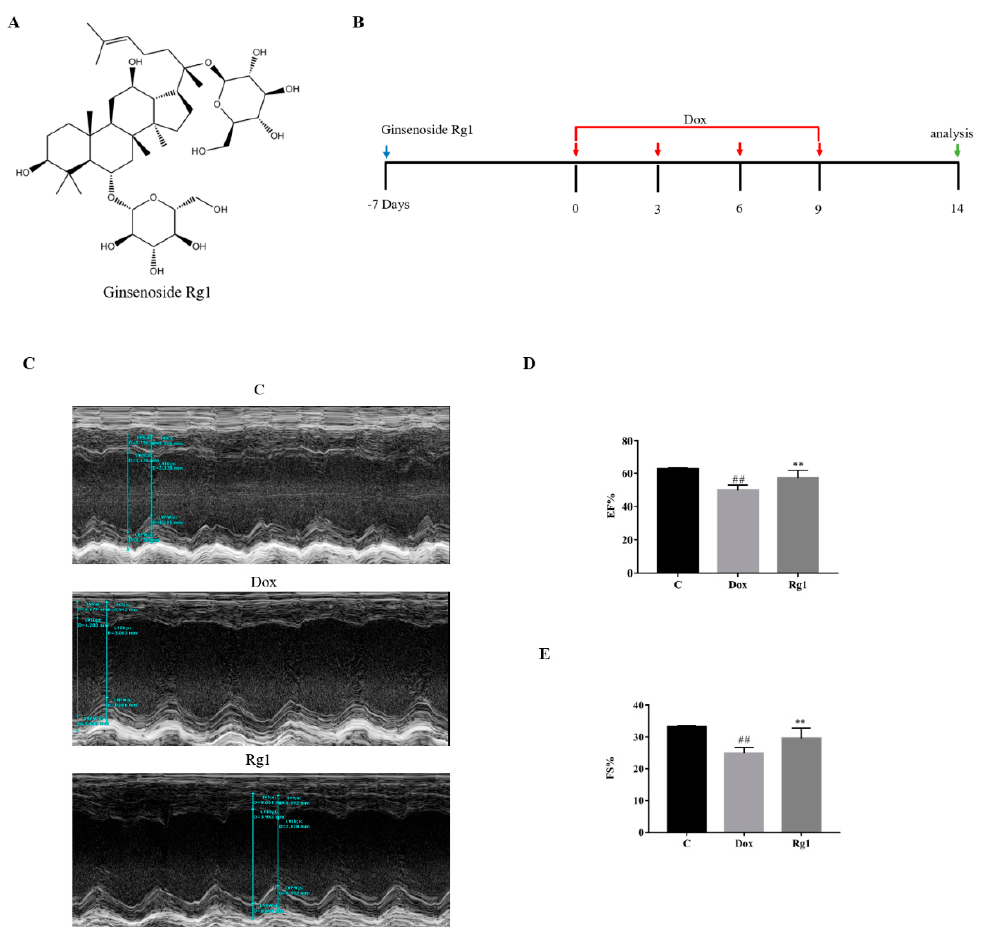
Figure 1. ( A ) Chemical structures of ginsenoside Rg1. ( B ) Schedule of the experiments. The mice received four doses of doxorubicin (6 mg/kg) or PBS every 3 d, as indicated. ( C ) Representative echocardiography images of left ventricle, ( D ) Echocardiographic measurement of EF (ejection fraction), ( E ) Echocardiographic measurement of fractional shortening (FS). ## p < 0.01 vs C group, ** p < 0.01 vs. DOX group. Int. J. Mol. Sci. 2018 , 19 , x FOR PEER REVIEW